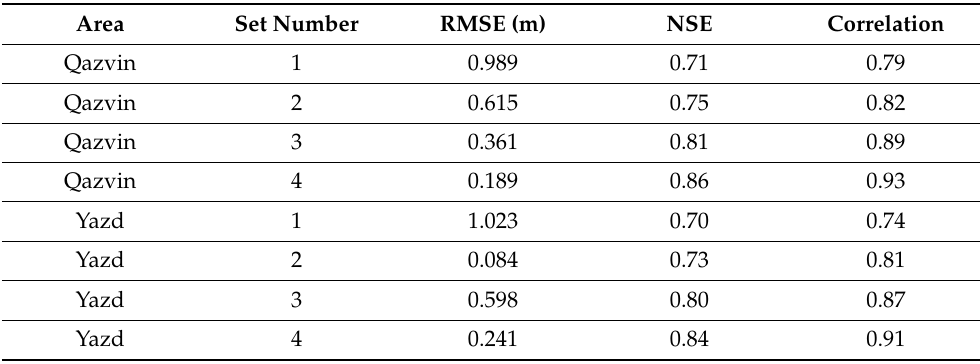
Table 7. The statistical results of different input sets of ANN.